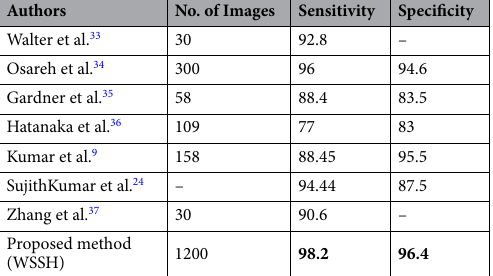
Table 4. Comparison of sensitivity and specificity values for the exudates classification. The bold indicate to our results that used to comparative with other